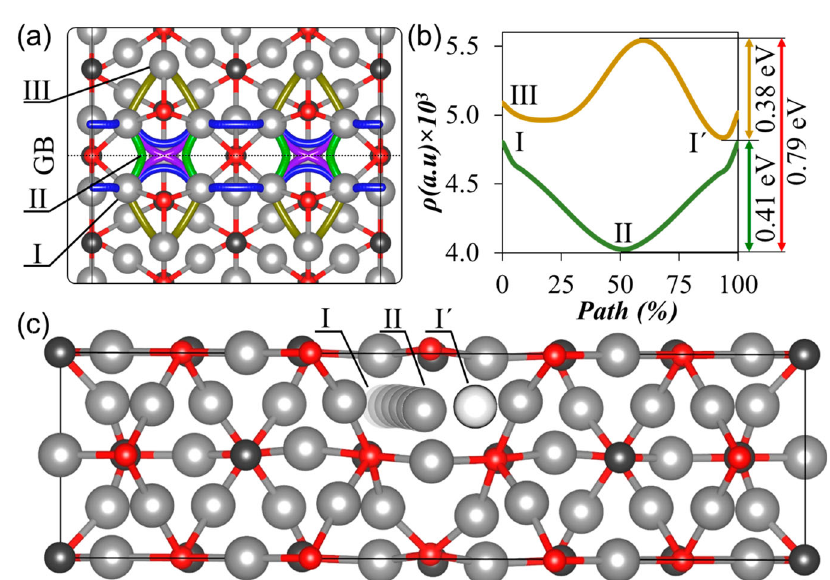
Fig. 4 Redistribution of Li ions and vacancies at the Σ 3(112) GB. a Low barrier pathways at the GB: 0.23 eV in blue, 0.25 eV in violet, 0.38 eV in yellow and 0.41 eV in green. b Electron density pro fi le of the pathways. Green, yellow, and red arrows represent values for the migration barrier for I-I´, I´-III and virtual II-III pathways. c DFT-relaxed geometry of the Σ 3(112) GB model. The white sphere represents a Li vacancy, and the gray trace shows Li-ion